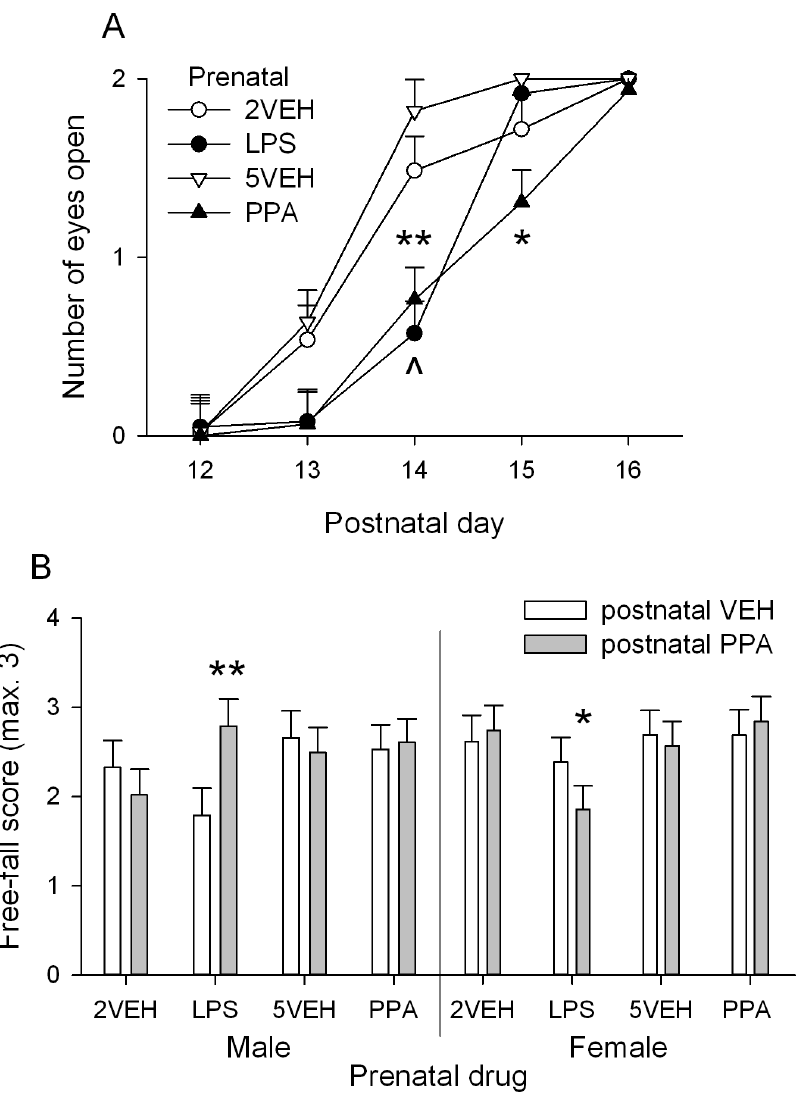
Figure 3. Developmental milestones for male and female offspring. A: Eye opening across postnatal days. Data is collapsed across sex and postnatal drug as there were no significant effects of these on eye opening. On P14, both prenatal LPS ( ‘ , p , 0.05) and PPA treated animals were delayed compared to vehicle treated controls. On P15, prenatal PPA treated pups continued to exhibit delayed eye opening. B: Free-fall righting reflex: 3 trials occurred, with a successful trial given a score of 1. In prenatal LPS treated pups, postnatal PPA produced sex differences, with higher scores in postnatal PPA treated males and lower scores in postnatal PPA treated females compared to postnatal VEH treated males and females, respectively. Error bars represent S.E.M. Refer to Table 1 for group designations and sample sizes. * p , 0.05, ** p ,